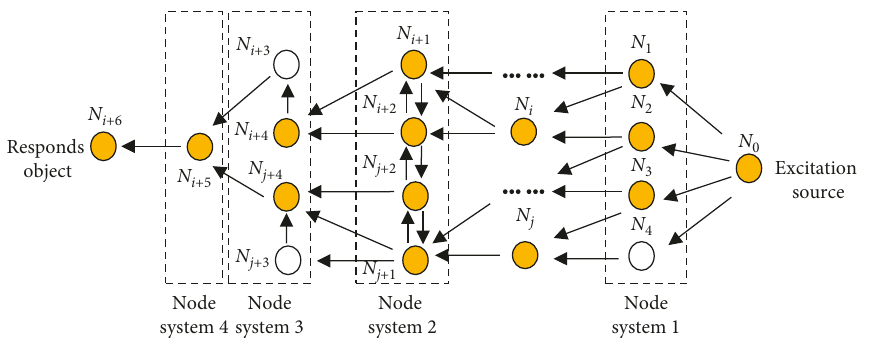
Figure 3: Division of the node system of the vibration transfer